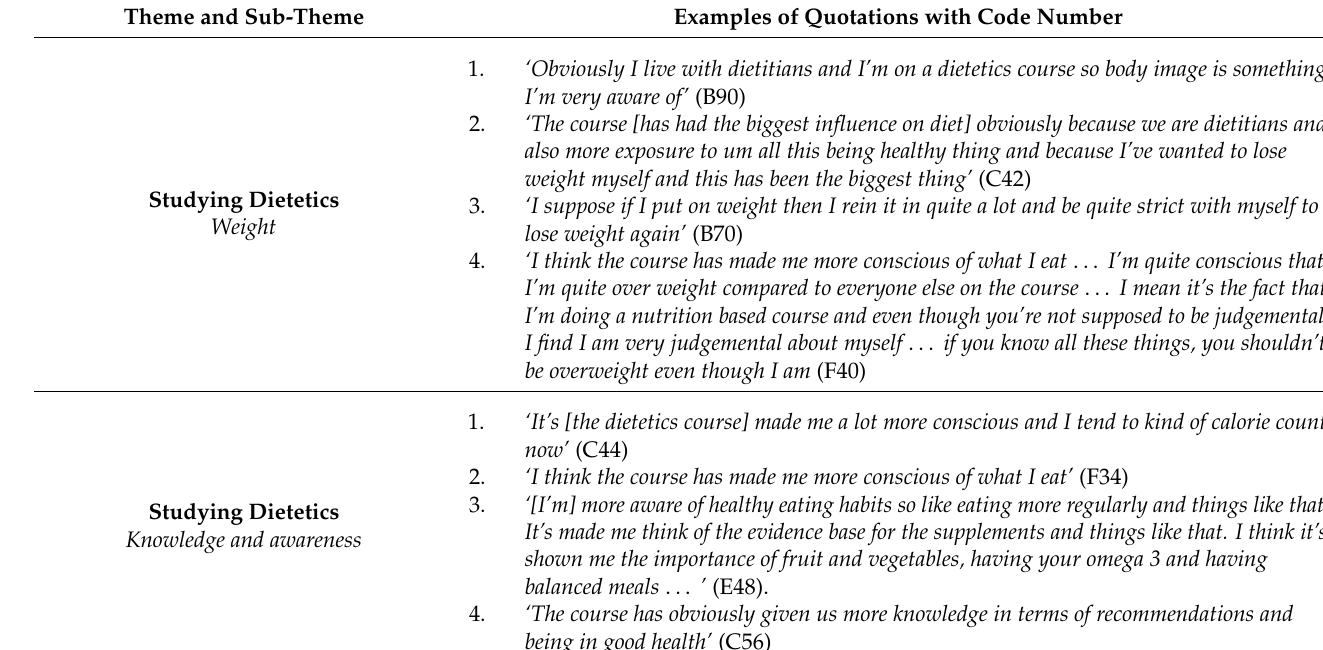
Table 3. Additional examples of the quotations to illustrate key themes and sub themes. Theme and